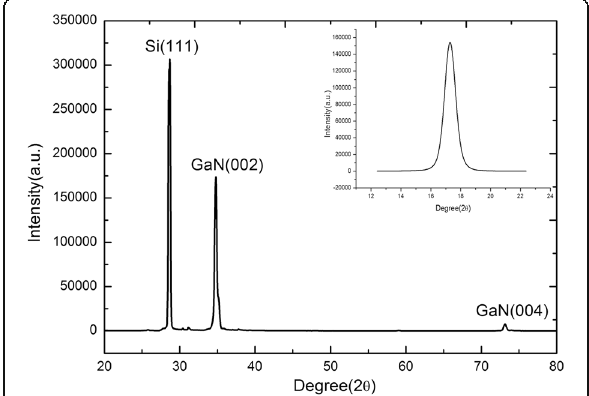
Fig. 4 X-ray diffraction pattern of the GaN nanowall network (S 2 ). The inset is the ω -scan rocking curve of the sample S 2